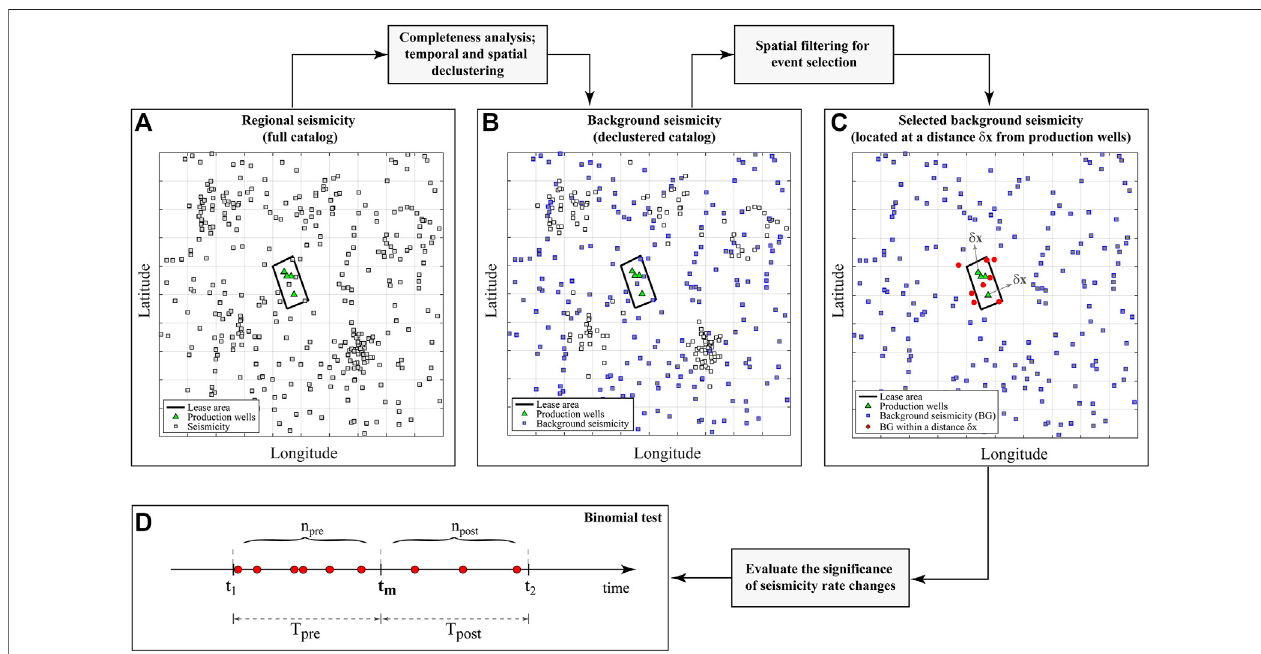
FIGURE 6 | Summary of the processing for selecting seismic data around a given production lease for the correlation analysis: (A) Regional seismicity around the lease, for which the M c is evaluated; (B) Identi fi cation of background seismicity from the regional catalog (considering events above M c ) using declustering techniques; (C) Spatial fi ltering by selecting events located within a distance δ x from production wells; (D) binomial test for evaluating the signi fi cance of seismicity rate changes.